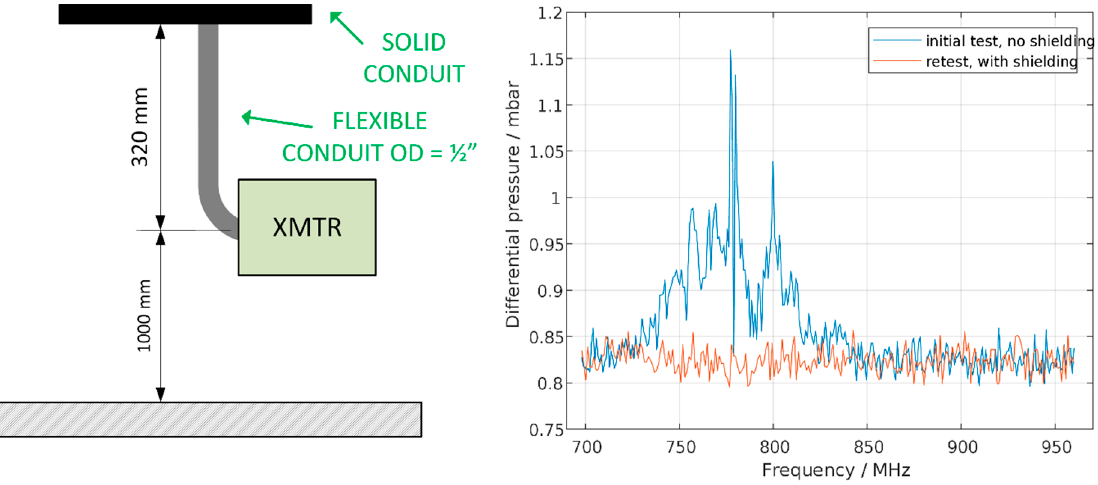
Figure 5. Transmitter installation detail and response of the measured output to EM noise with and without additional shielding.